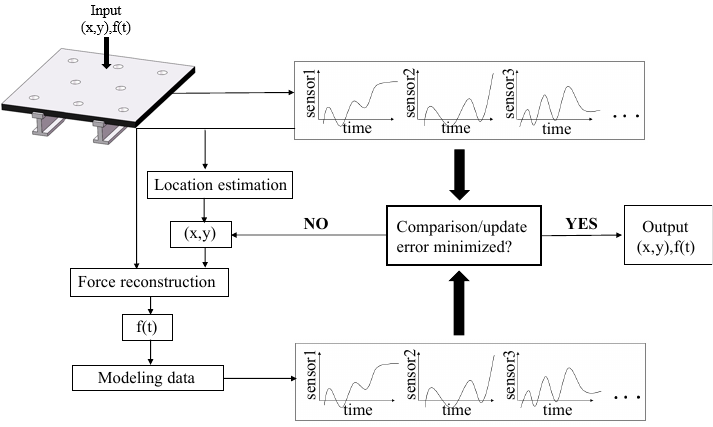
Figure 10. The principle of model-based methods.